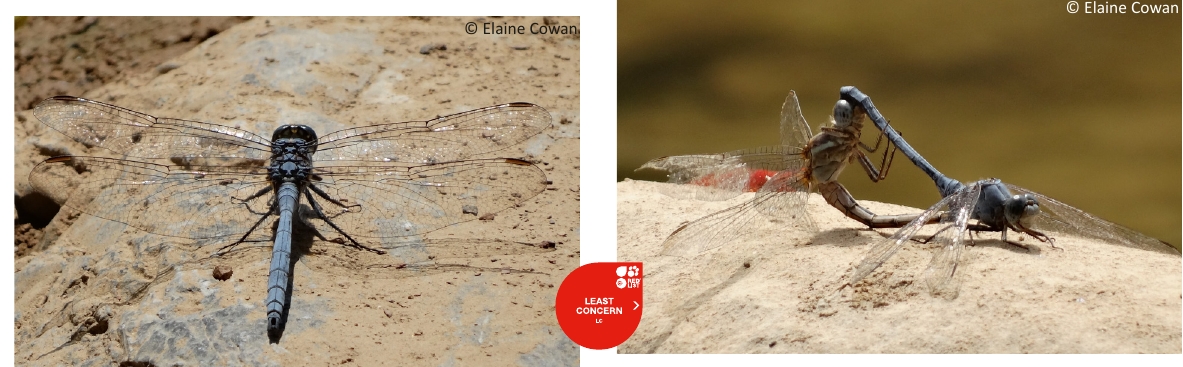
Image 15. Orthetrum chrysostigma mating wheel, 23 April 2014. Female brown with a lateral whitish dark-bordered thoracic